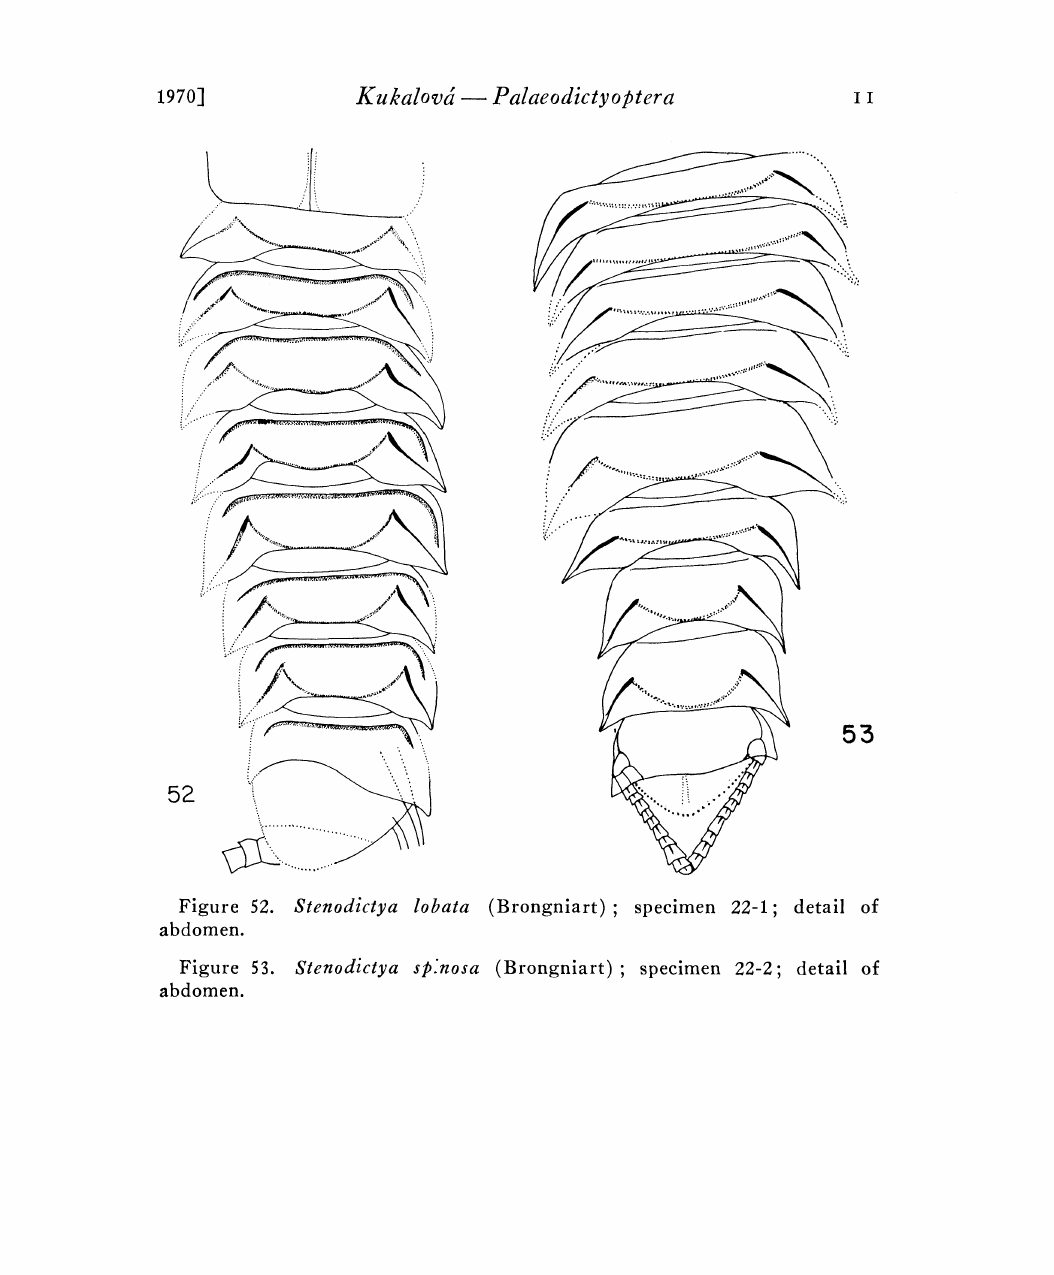
Figure 52. Stenodictya lobata (Brongniart); specimen 22-1; detail of abdomen. Figure 53. Stenodictya sp[nosa (Brongniart); specimen 22-2; detail of